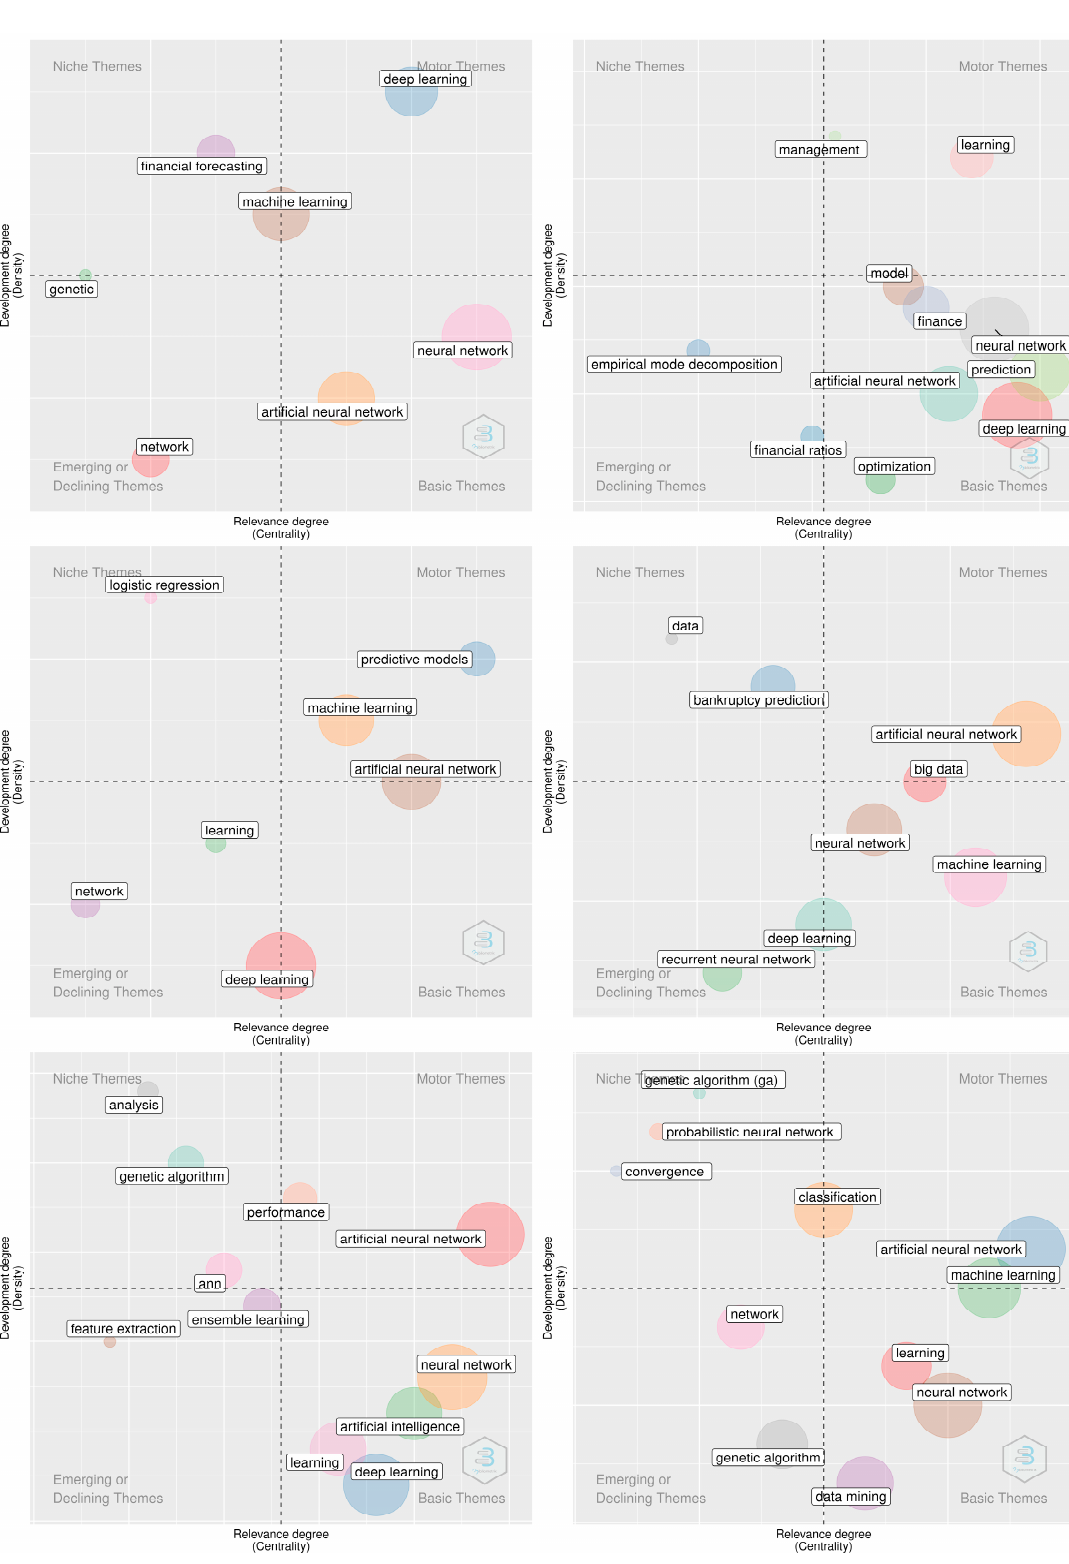
Figure 4. Topic modeling, overall period, and per year.